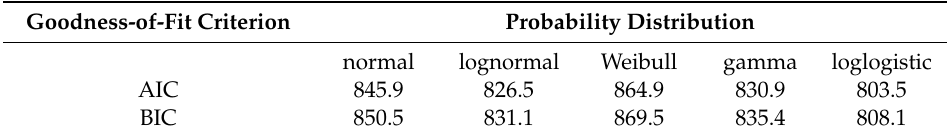
Table 2. Goodness-of-fit criterion for the lactating cow feed data case.